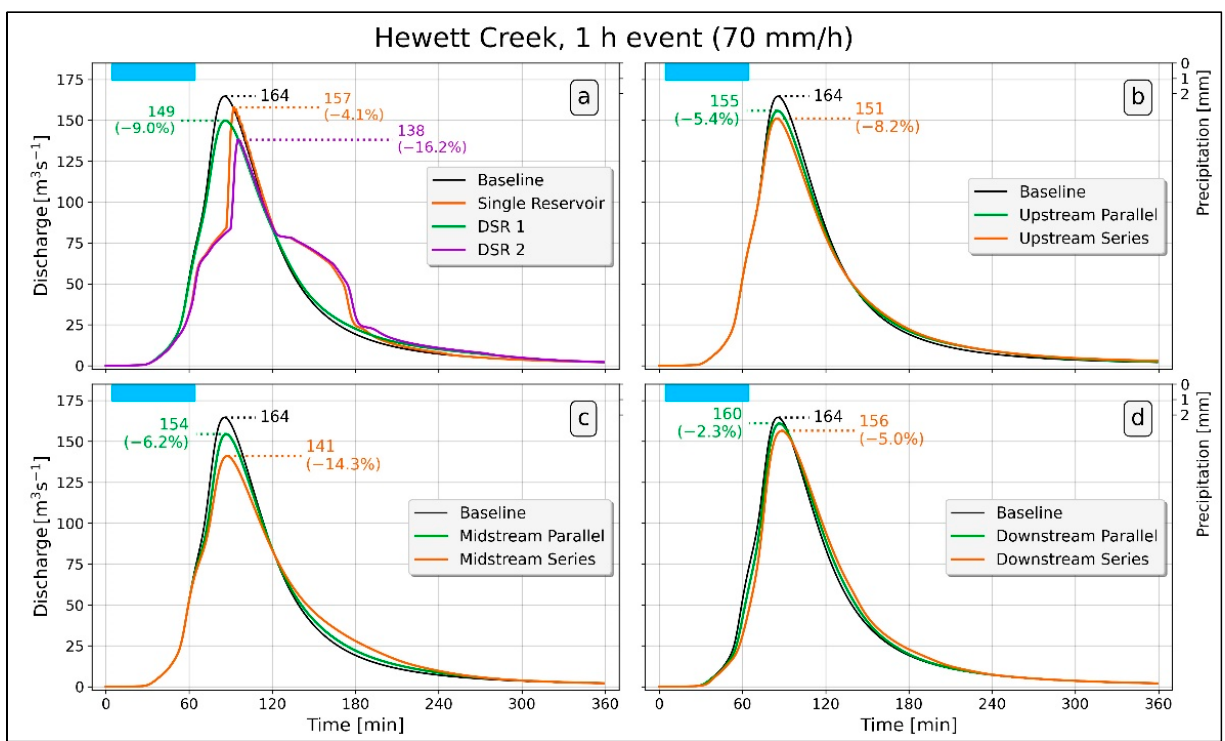
Figure 7. Hydrograph for ( a ) single large reservoir, DSR 1, and DSR 2 distributions, ( b ) upstream, ( c ) midstream, ( d ) downstream distributions.